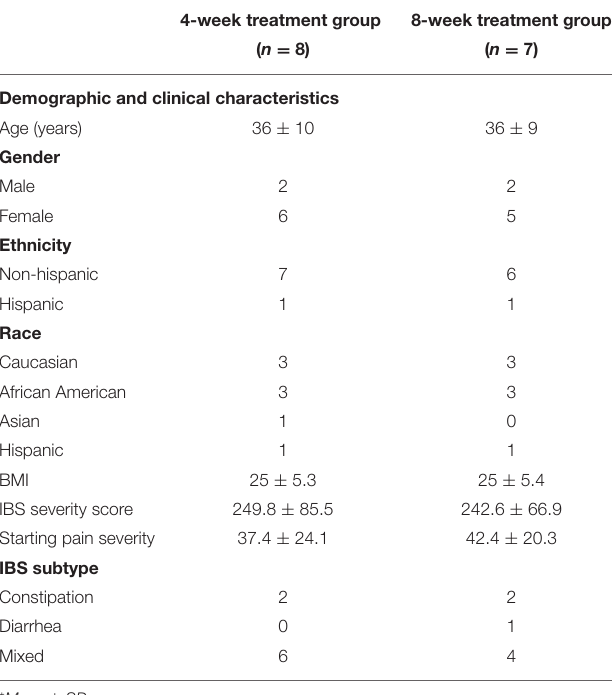
TABLE 2 | Demographic and clinical characteristics of 4- and 8-weeks treatment group.